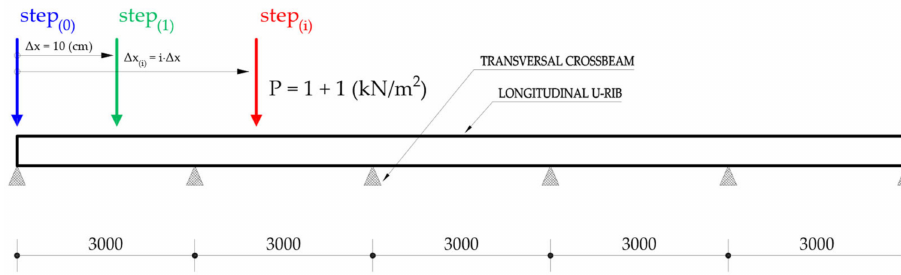
Figure 17. Loading steps—Footprint with unitary pressures.